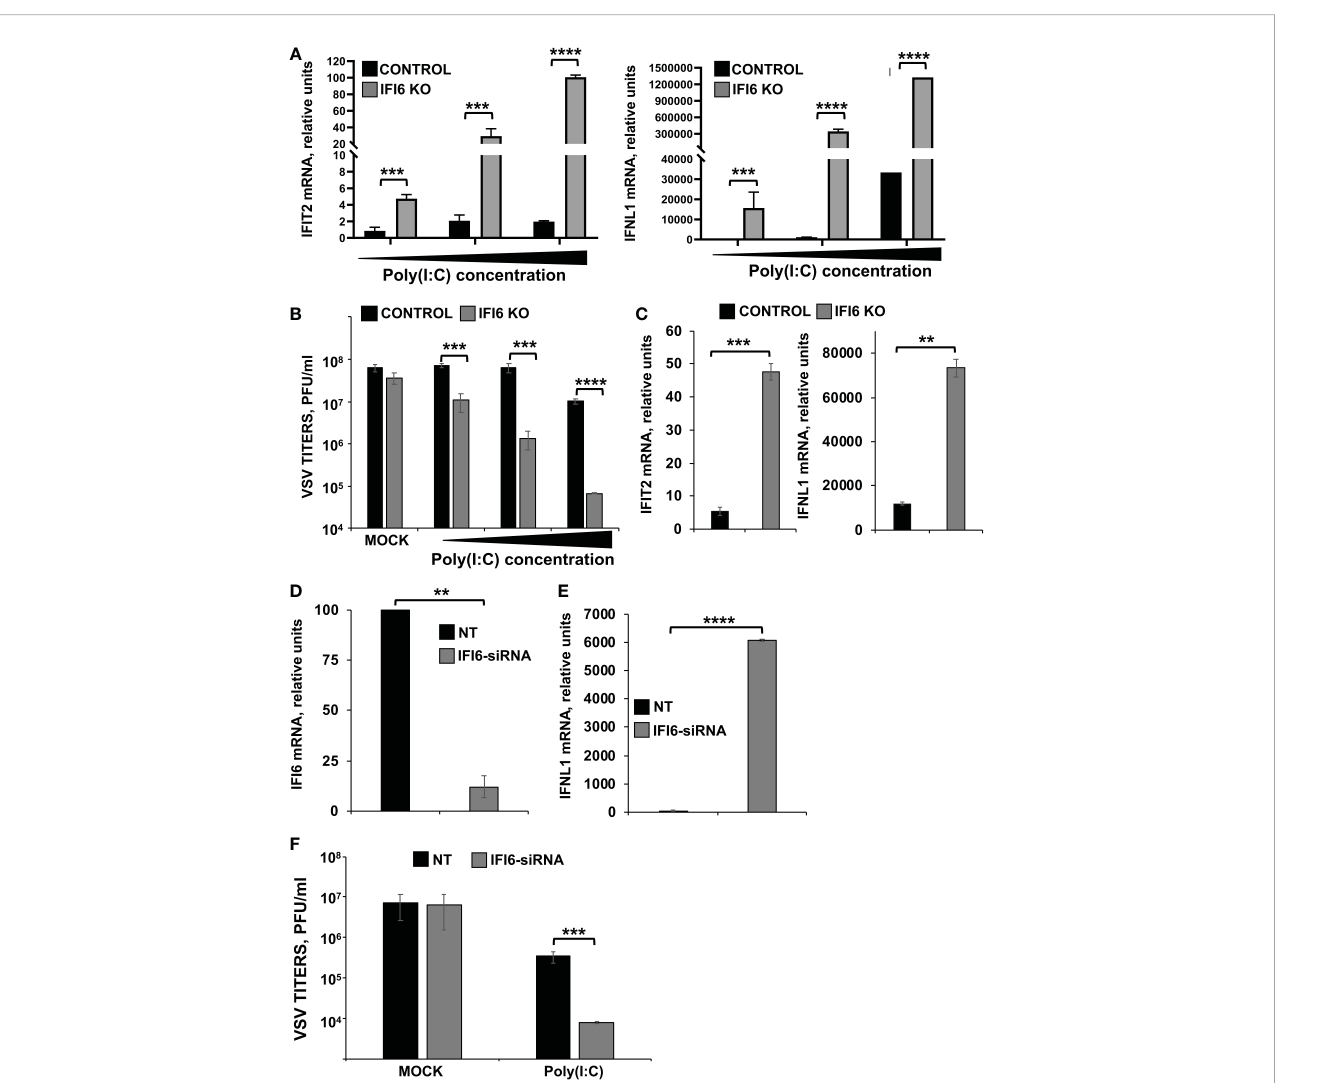
FIGURE 4 Effect of IFI6 on the modulation of innate immune responses induced by poly(I:C). (A, B) Effect of IFI6 knocking-out . (A) Human HAP-1 IFI6 KO and WT cells were treated with three different concentrations of poly(I:C) (750; 1,500; and 3,000 ng/ml). (A) To analyze the effect of IFI6 on innate immune responses, the levels of IFIT2 and IFNL1 were evaluated by RT-qPCR at 24 hpt, and mRNA levels were expressed as fold change (increases) in comparison to mock-treated cells, used as controls. (B) Mock-treated cells, or cells transfected with three different concentrations of poly(I:C), were infected with rVSV-GFP (MOI of 0.1), and viral titers at 24 hpi were measured by a lysis plaque assay. Three different experiments were performed, with similar results. ***P<0.001, ****P<0.0001 (using Student ’ s t test). (C) Human HAP-1 parental and IF6 KO cells were infected for 24 h with SeV. The levels of IFIT2, and IFNL1 were measured by RT-qPCR and mRNA levels were expressed as fold change (increases) in comparison to mock-infected cells, used as controls. **P<0.01, ***P<0.001 (using Student ’ s t test). (D – F) Effect of IFI6 silencing . (D – F) Human HAP-1 cells were transfected with NT or an IFI6 siRNA. (D) At 24 hpt, total RNAs were puri fi ed and mRNA levels for IFI6 were analyzed by RT-qPCR. (E) At 24 hpt, cells were transfected with poly(I:C). To analyze the effect of IFI6 on innate immune responses, the levels of IFNL1 were evaluated by RT-qPCR at 24 hpt, and increases in mRNA levels were expressed as fold change in comparison to mock-treated cells, used as controls. (F) Cells that had been subjected to mock treatment, or transfected with polyIC, were infected with rVSV-GFP (MOI of 0.1), and viral titers at 24 hpi were measured by a lysis plaque assay. Three different experiments were performed, with similar results. **P<0.01, ***P<0.001, ****P<0.0001 (using Student ’ s t